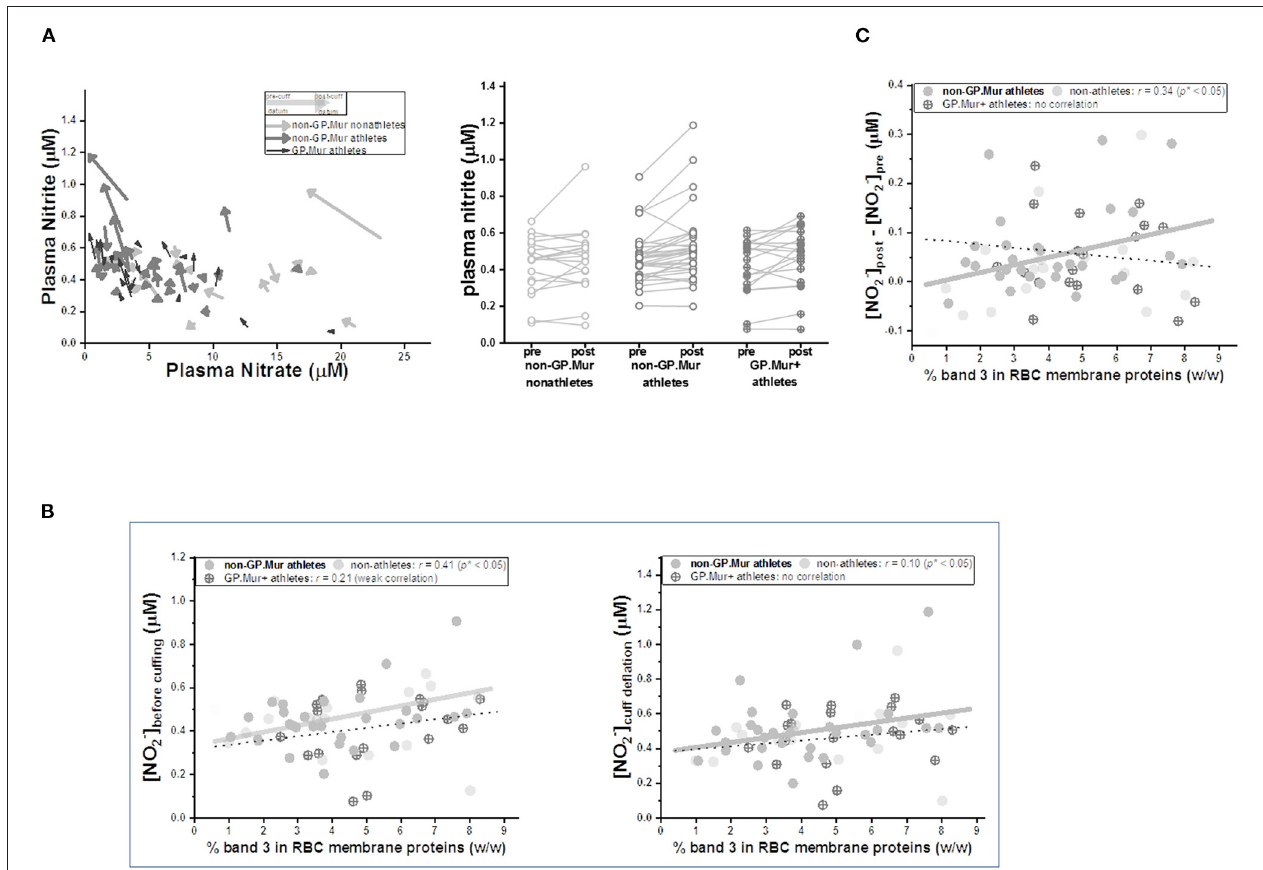
FIGURE 4 | Arterial occlusion following cuff deflation during FMD decreased plasma nitrate and increased nitrite, the latter of which was quantitatively directly correlated with individual erythroid band 3 levels. (A) LEFT: Plasma nitrite and nitrate levels before cuffing and upon deflation were compared. Their changes ( 1 [NO − 2 ] and 1 [NO − 3 ]) were generally inversely correlated. Each arrow represents a test subject: GP.Mur athletes in black color, non-GP.Mur athletes in dark gray color, and non-GP.Mur non-athletes in light gray color. The beginning of an arrow indicated concentrations of plasma nitrite and nitrate right before cuffing; the arrowhead indicated concentrations of plasma nitrite and nitrate upon release of the cuff pressure. RIGHT: Plasma nitrite generally increased upon cuff deflation following 5-min arterial occlusion. Each line connected the nitrite concentration before arm cuffing and the concentration upon pressure deflation for an individual subject. (B) The concentrations of blood plasma nitrite were directly proportional to individual band 3 levels. The thick gray line indicated significant linear fitting for non-GP.Mur (* p < 0.05); the thin dashed line indicated poor linear fitting for GP.Mur data ( n.s. ). LEFT: the concentration of plasma nitrite ([NO − 2 ]) before cuffing. RIGHT: [NO − 2 ] upon cuff deflation following 5-min occlusion of the brachial artery. (C) For all non-GP.Mur subjects (athletes and non-athletes), their changes of blood nitrite concentrations by arterial occlusion during FMD ( 1 [NO − 2 ] cuffing = [NO − 2 ] pre − cuff - [NO − 2 ] upon deflation ) was directly correlated with erythroid band 3 levels (* p < 0.05). This direct relation between band 3 and ( 1 [NO − 2 ] cuffing ) was not apparent in GP.Mur +